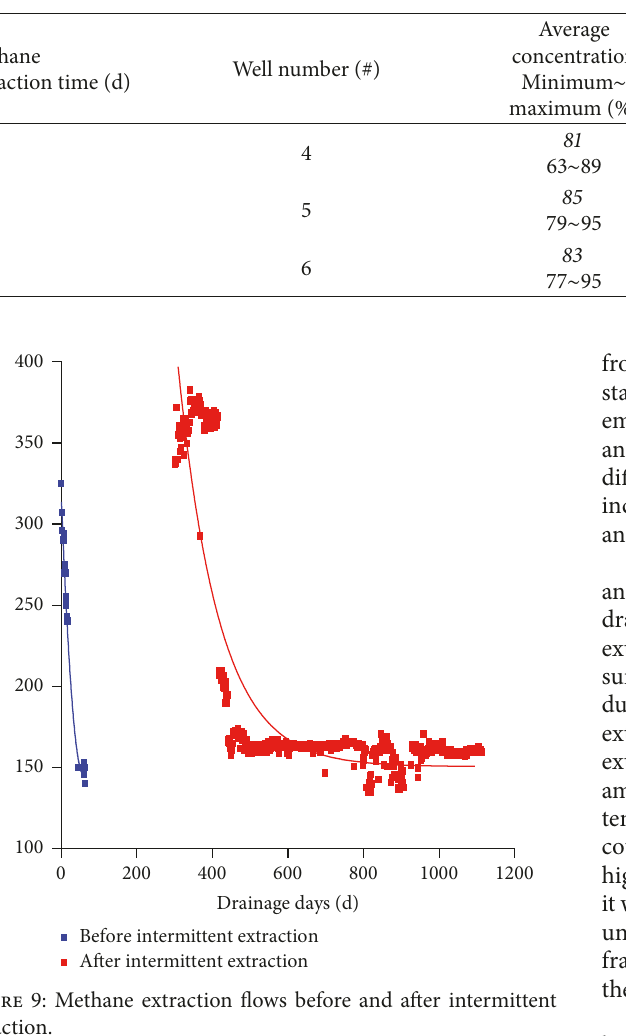
Table 2: Representative methane extraction effect of surface wells in the abandoned mine.